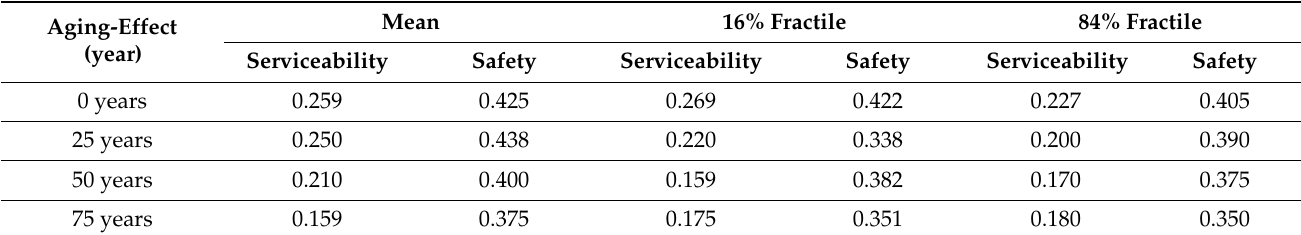
Table 2. Peak ground acceleration (PGA) (g) for each limit states from the IDA.